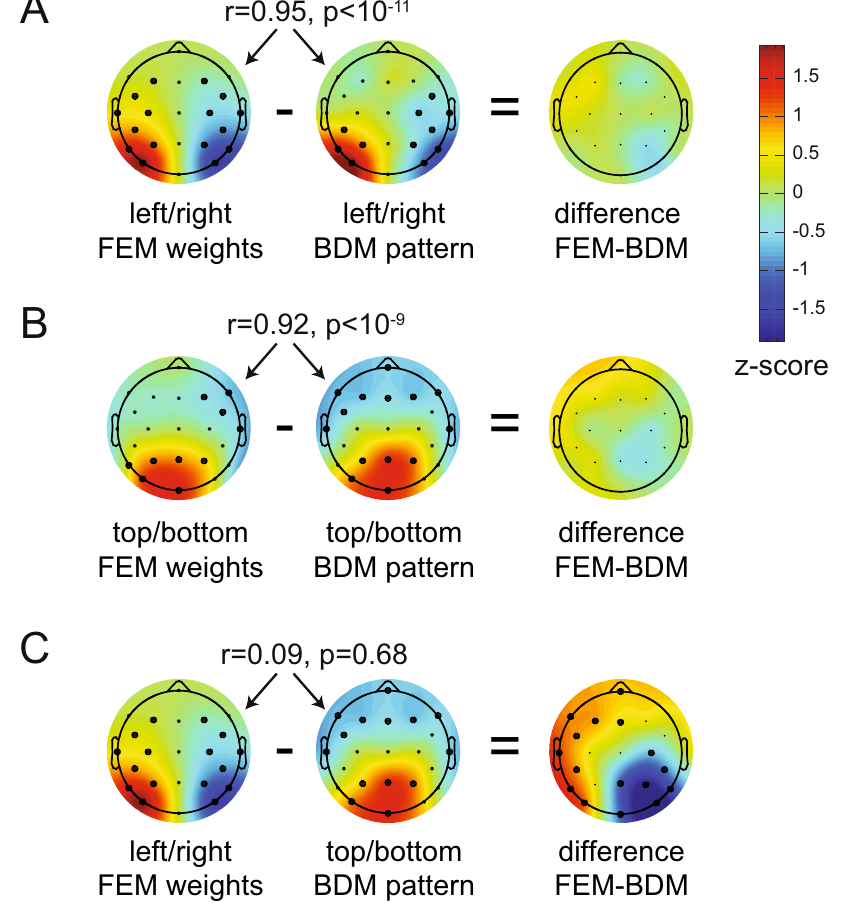
Figure 10. Comparing reconstructed weights in Experiment 2 to actual patterns in Experiment 1. The pearson correlation across population-averaged electrodes between FEM (Forward Encoding Model) weights from experiment 2 and BDM (Backward Decoding Model) patterns from experiment 1, as well as the unpaired t-test difference between FEM and BDM. ( A ) FEM and BDM left-right patterns show a high correlation and no significant differences. ( B ) FEM and BDM top-bottom patterns show a high correlation and no significant differences. ( C ) To show that the absence of significant differences in ( A ) and ( B ) is not caused by a lack of power due to t-testing between rather than within subjects, we also compare left-right FEM weights to the top- bottom BDM weights. These do not correlate, while their difference shows two large significant clusters. Thick electrode dots belong to clusters that have p < 0.01 under cluster based permutation